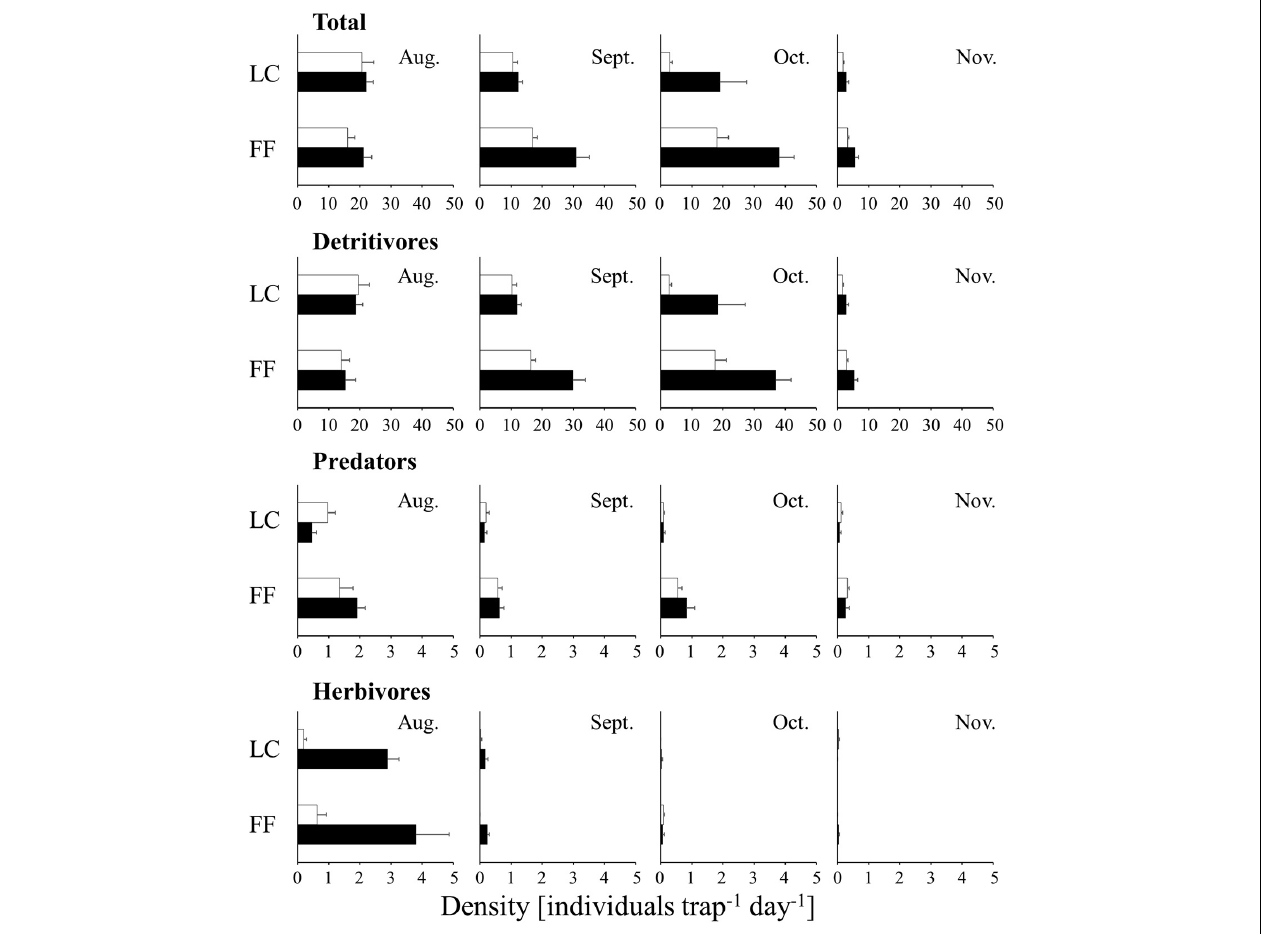
FIGURE 3 | Temporal changes in the density of wandering arthropods collected by trunk-sticky traps in the vertical strata of a Japanese cedar ( Cryptomeria japonica ) forest. The black and white bars indicate upper and lower sticky bands, respectively. Values represent mean ± standard error. LC, lower canopy; FF, forest floor.